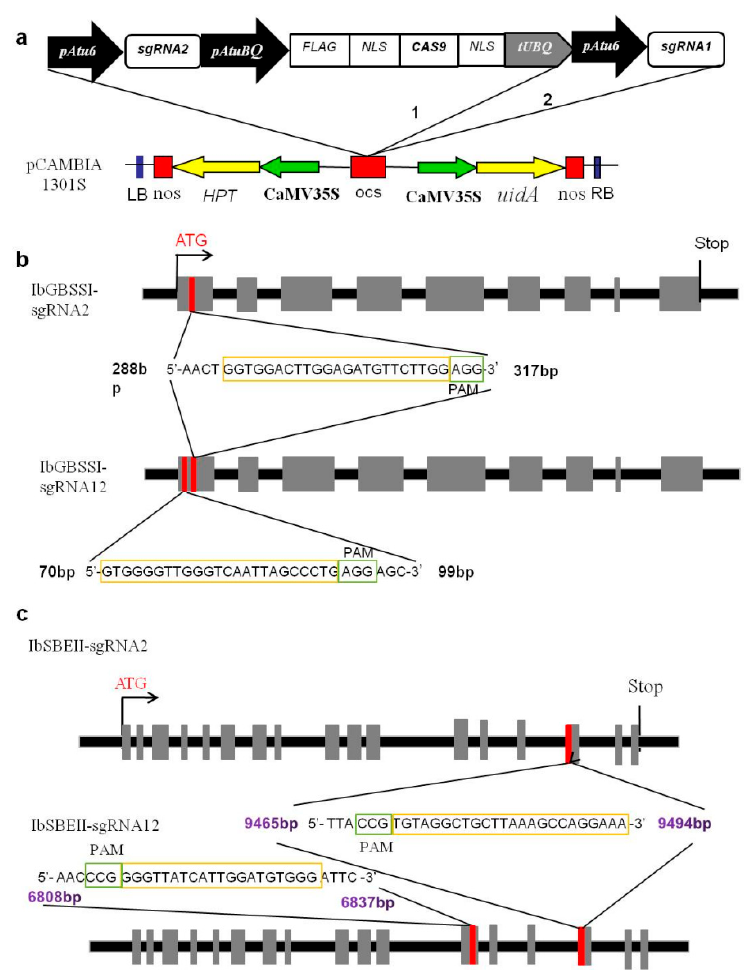
Figure 1. Schematic representations of the sweet potato granule-bound starch synthase I ( IbGBSSI ), and starch branching enzyme II ( IbSBEII ) target genes, location of the gRNAs, and CRISPR / Cas9 gene-editing construct. ( a ) Structural organization of the CRISPR / Cas9 binary vector pCAMBIA1301s used for stable Agrobacterium -mediated transformation in the sweet potato. Arabidopsis thaliana promoter AtU6 drives expression of each gRNA. The cauliflower mosaic virus promoter (CaMV 35S) drives expression of the Cas9 gene. Abbreviations: 1, single gRNA vector; 2, double gRNAs vector; NLS, nuclear localization signal; Nos, Nos terminator. ( b ) Schematic representation of encoding granule-bound starch synthase I (IbGBSSI) target region and location of the gRNAs. Exons are shown as square frames and surrounding introns appear as lines. sgRNA and PAM are highlighted in yellow and green, respectively. ( c ) Schematic representation of IbSBEII target region and location of the gRNAs. Exons shown as square frames and surrounding introns appear as lines. sgRNA and PAM are highlighted in yellow and green, respectively.